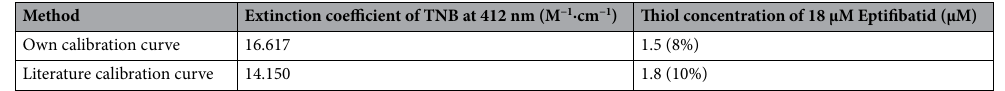
Table 1. Thiol concentration of 18 µM spin labeled eptifibatid based on the calibration curve depicted in Fig. 3b or by exploiting the extinction coefficient of TNB (2-nitro-5-thiobenzoic acid) according to the literature 60–62 .